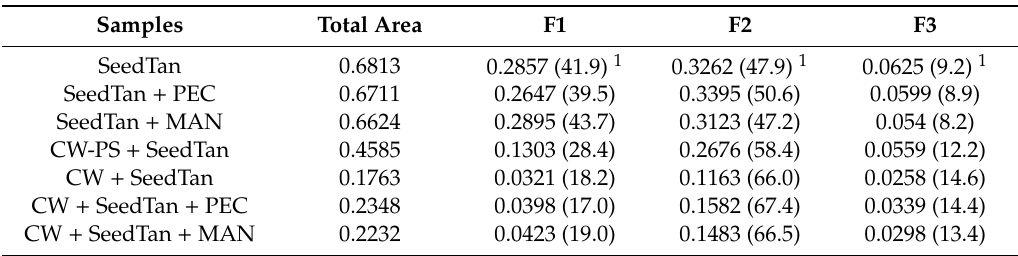
Table 4. Total area measured in the SEC analysis for the seed tannin in the model solution and area corresponding to high molecular mass (F1), medium molecular mass (F2), and low molecular mass phenolic compounds (F3).